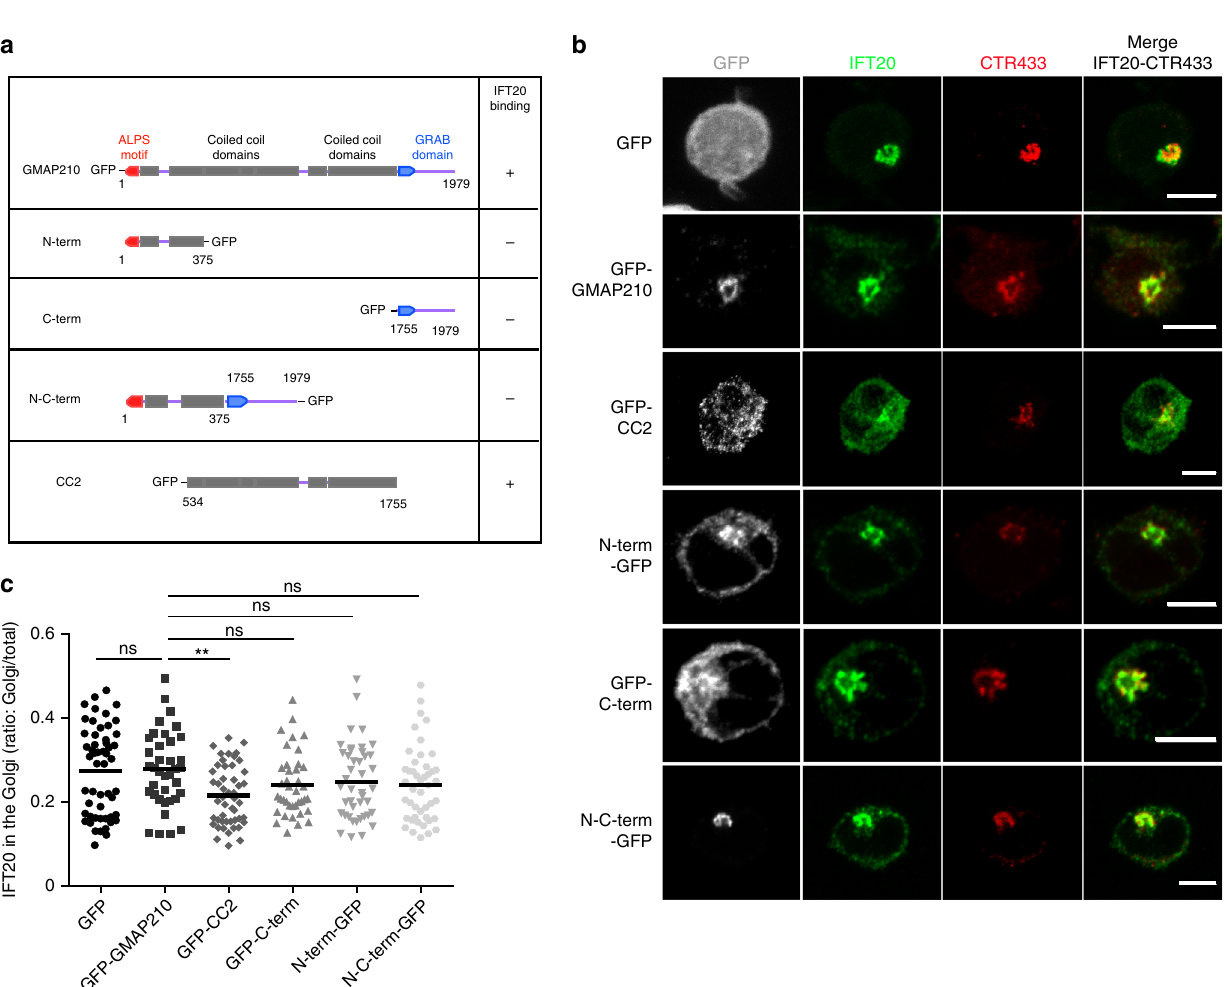
Fig. 6 IFT20 localization in the Golgi in Jurkat cells expressing different GMAP210-GFP domains. a Schematic representation of GMAP210 and fusion constructs with different IFT20-binding capacity. b Confocal images showing the relative localization of IFT20 (green) and CTR433 (red) in Jurkat cells expressing GFP, GFP-GMAP210, or different GMAP210 domains coupled to GFP. c Quanti fi cation of the ratio of IFT20 fl uorescence present in the Golgi versus total fl uorescence in the different conditions. Scale bar 5 μ m. Each dot = one cell; horizontal lines = median. ** P < 0.01, ns: non-signi fi cant (one-way ANOVA). Data and images represent two independent experiments in b and